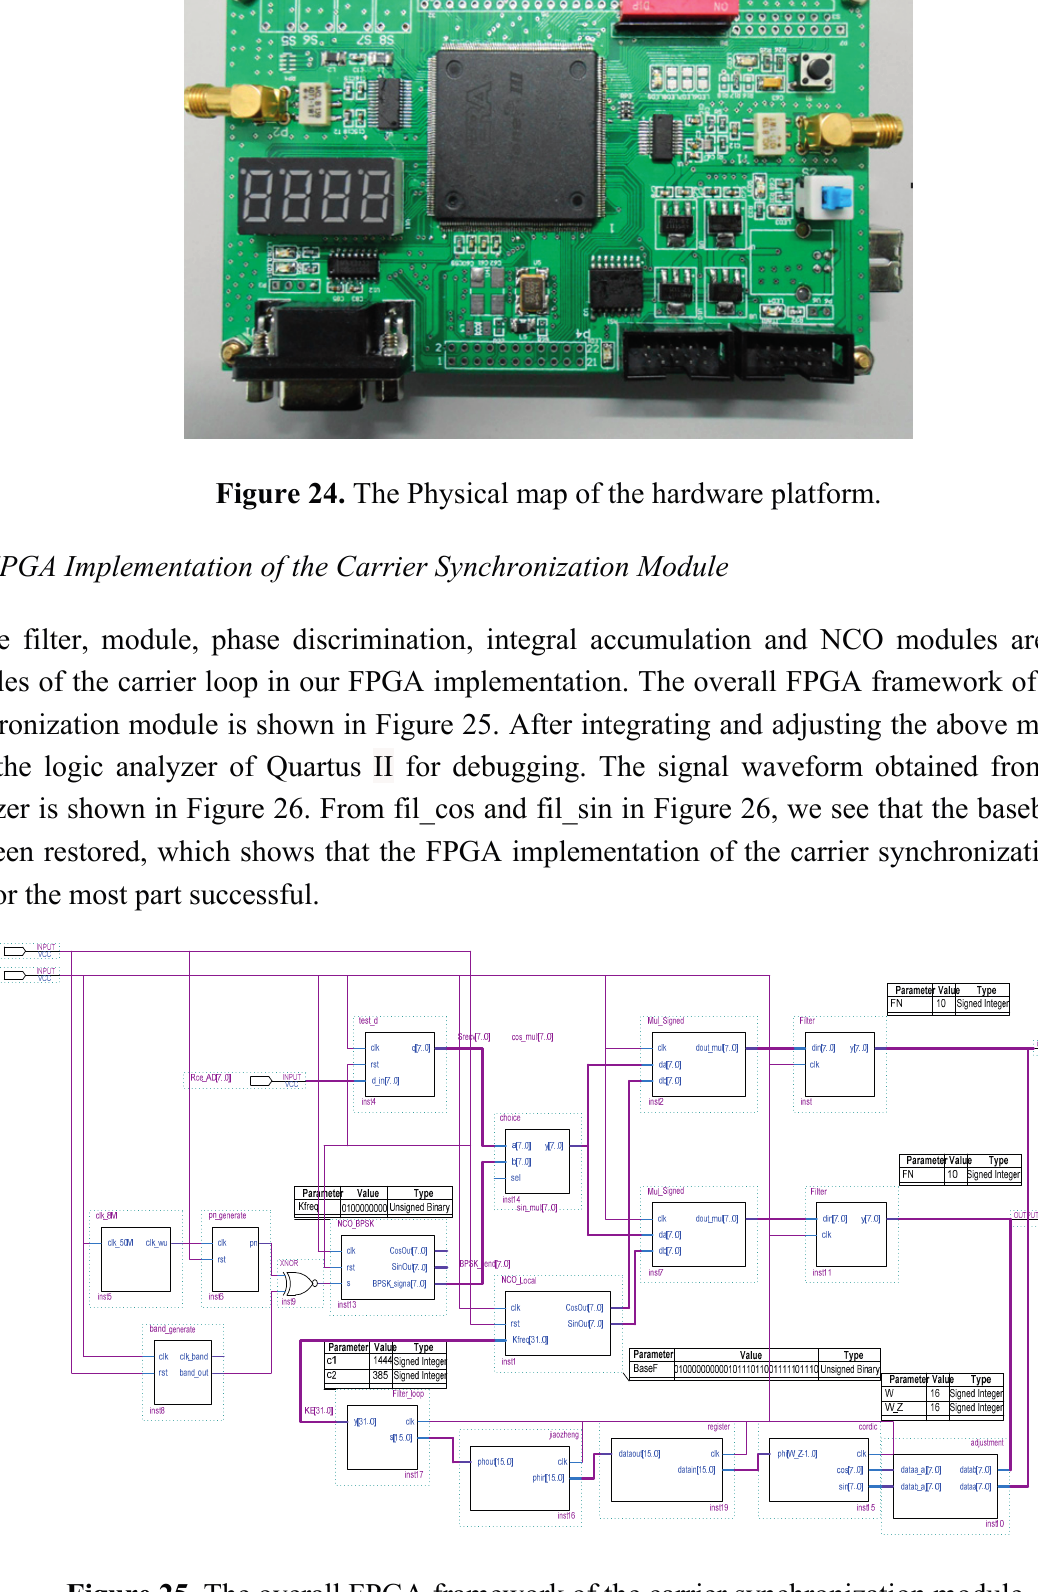
Figure 25. The overall FPGA framework of the carrier synchronization